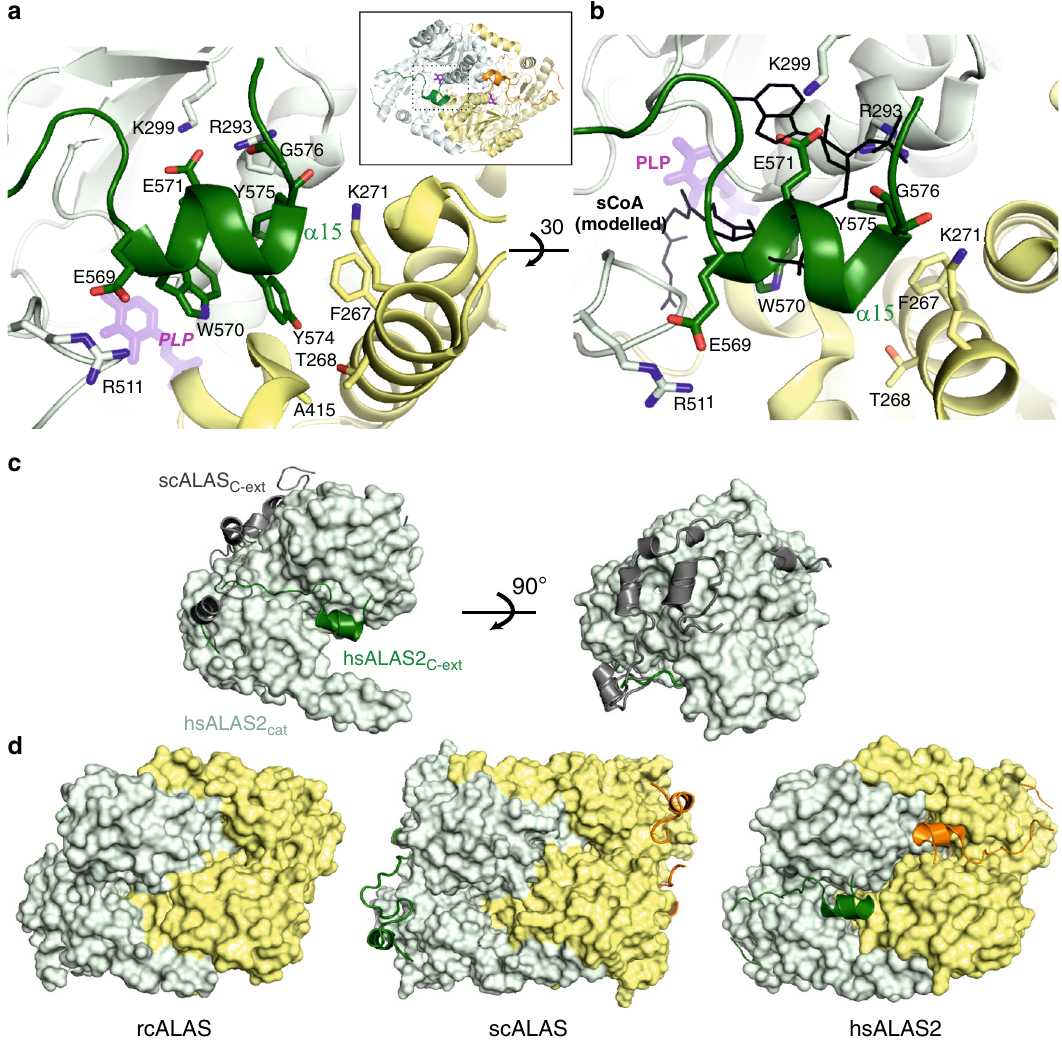
Fig. 2 hsALAS2 C-terminal extension is mobile and interferes directly with active site. a Interactions of helix α 15 from the Ct-extension (dark green) with the catalytic core of monomer A shown in light green and the opposing monomer B shown in yellow. b Similar view as panel A, related by 30° rotation along the horizontal axis. The succinyl-CoA (sCoA) ligand, modeled into hsALAS2 from rcALAS (PDB 2BWO), is shown in black lines to highlight steric clashes with helix α 15. c hsALAS2 monomer with catalytic domain in surface representation (light green) and Ct-extension in cartoon representation (dark green). The scALAS Ct-extension is also superimposed in cartoon representation (gray). d rcALAS (PDB 2BWN), scALAS (PDB 5TXR) and hsALAS2 (this study) homodimers. Catalytic domains are shown in surface representation (monomer A light green, monomer B yellow). Ct-extensions are shown in cartoon representation for scALAS and rcALAS (dark green for monomer A, orange for monomer